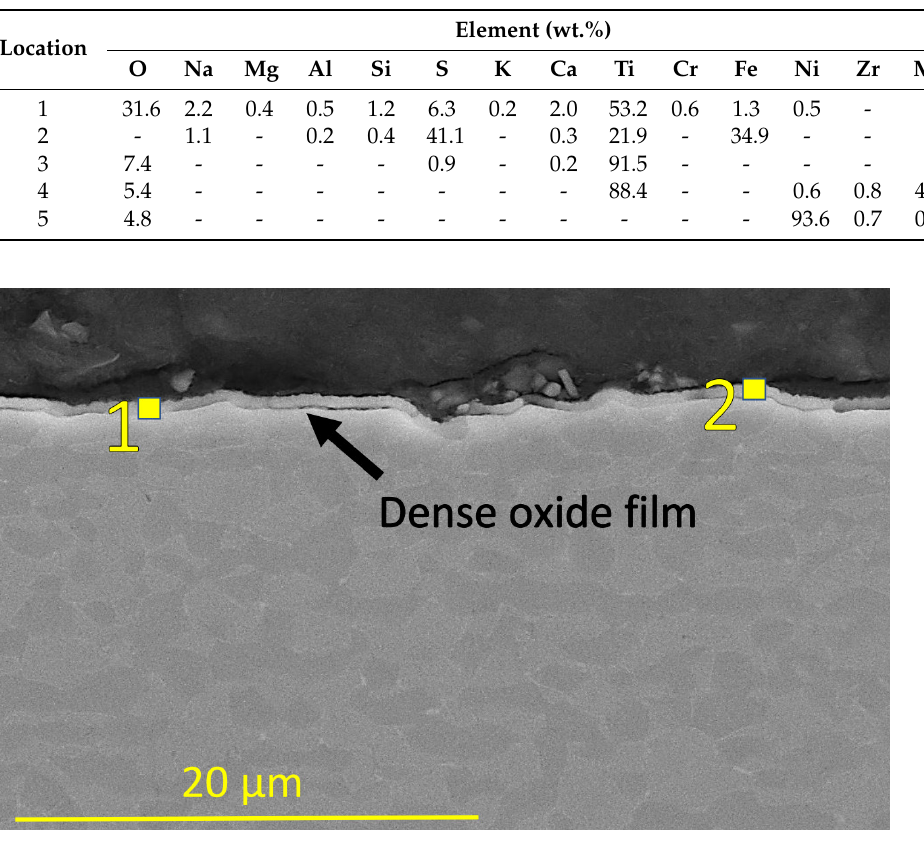
Figure 15. SEM and XEDS analysis of the cross-section of tested titanium alloy sample 1 at 1 cm from the inlet end of the first reactor. Table 13. Elemental analysis from locations in Figure 15.